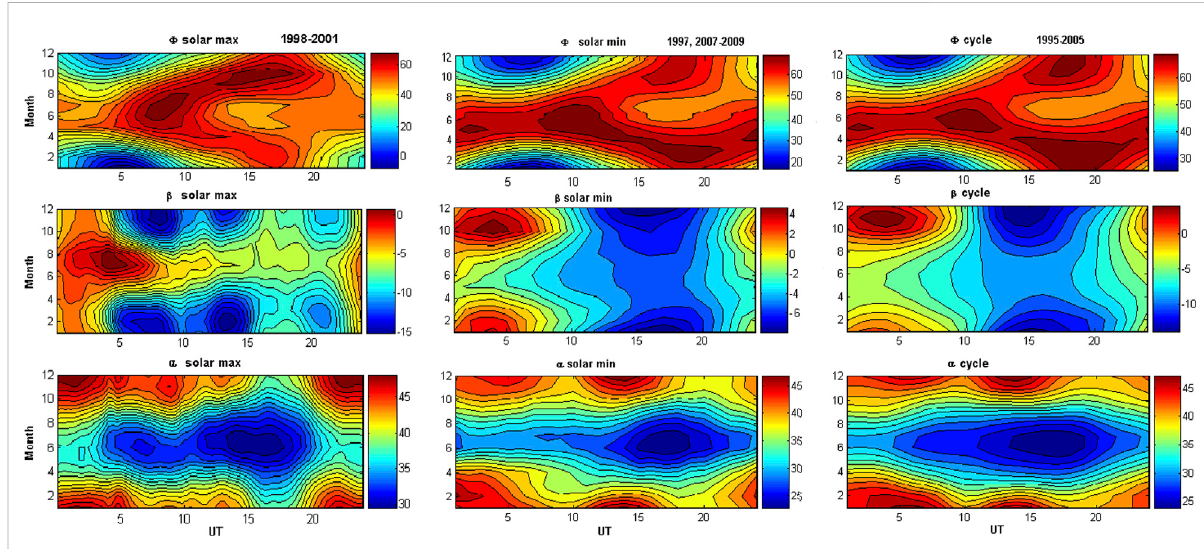
FIGURE 6 Parameters Φ (1st panel) , β (2nd panel) and α (3rd panel) , derived for the Vostok station for epochs of solar maximum (left column), solar minimum (middle column), and for the full cycle of solar activity 1995 – 2005 (right column), the axis of abscises being for UT and axis of ordinates being for month (Troshichev et al.,